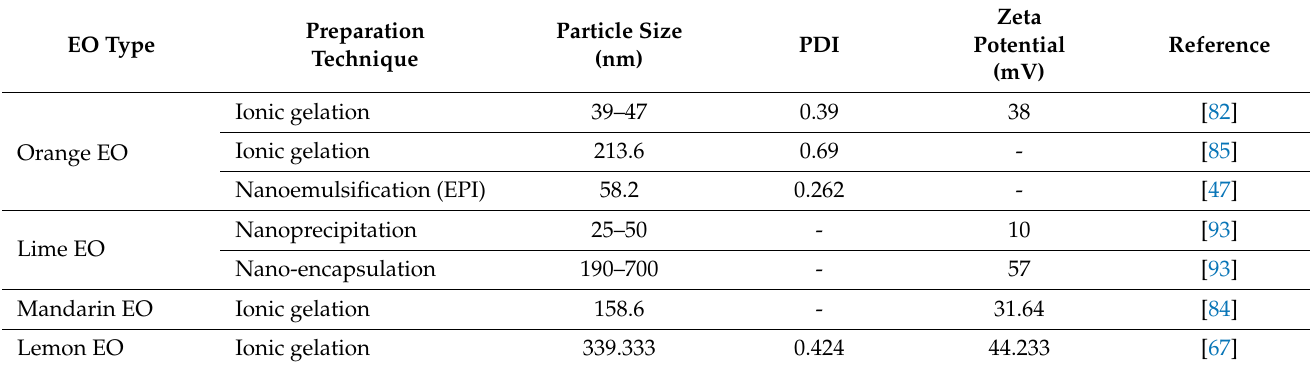
Table 3. Comparison of physical-chemical parameters of chitosan nanostructures of different citrus